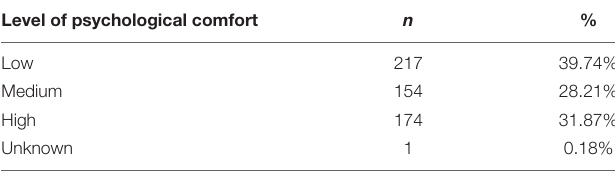
TABLE 2 | The distribution of the variable level of psychological comfort.